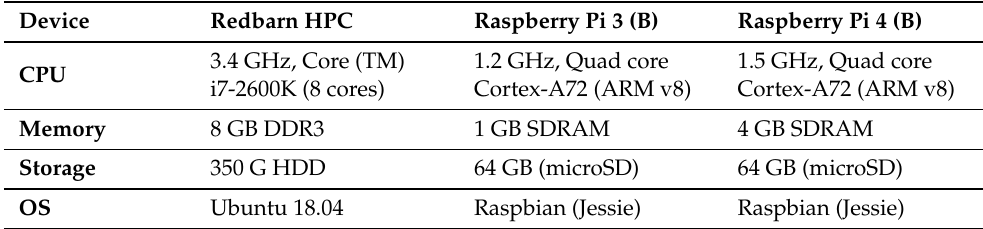
Table 2. Configuration of experimental nodes.